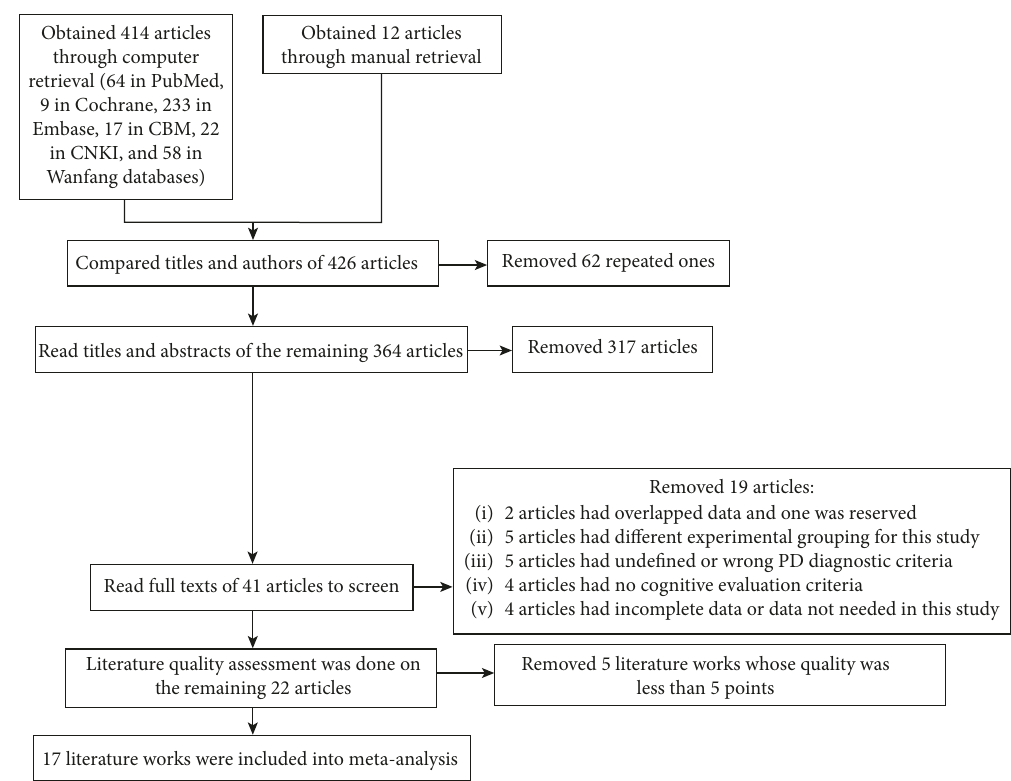
Figure 1: Flow chart of the study retrieval